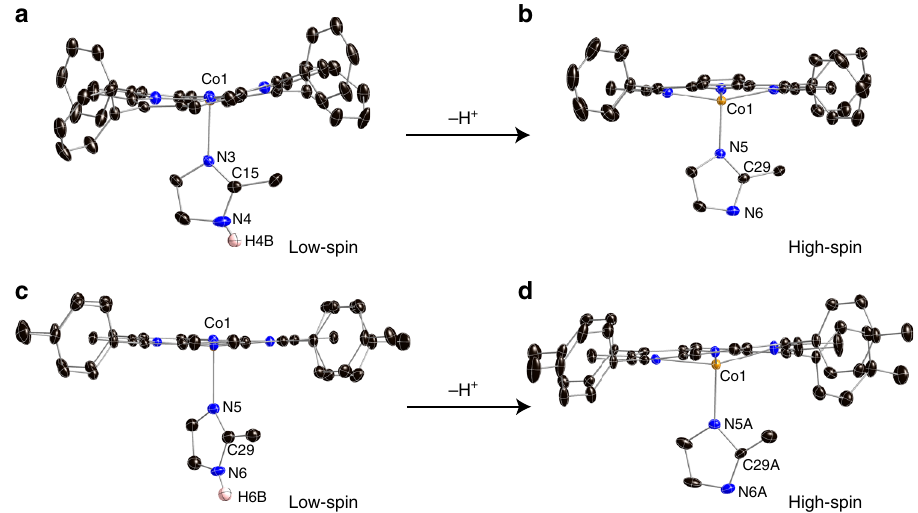
Fig. 1 ORTEP diagrams. a [Co(TPP)(2-MeHIm)]. b [Co(TPP)(2-MeIm − )] − . c [Co(TTP)(2-MeHIm)] (one of the two orientations is shown for the axial molecules are not shown for